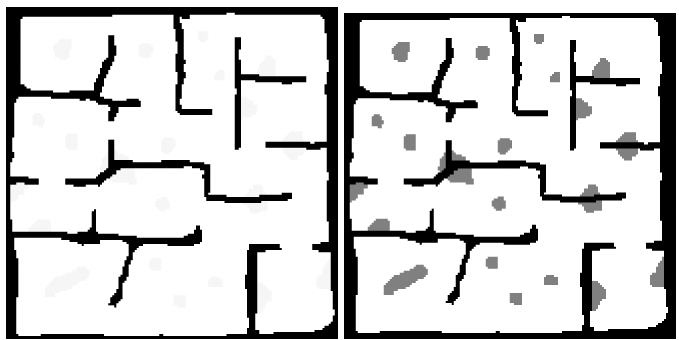
Figure 1. Prior Knowledge of the Environment vs. True State of the